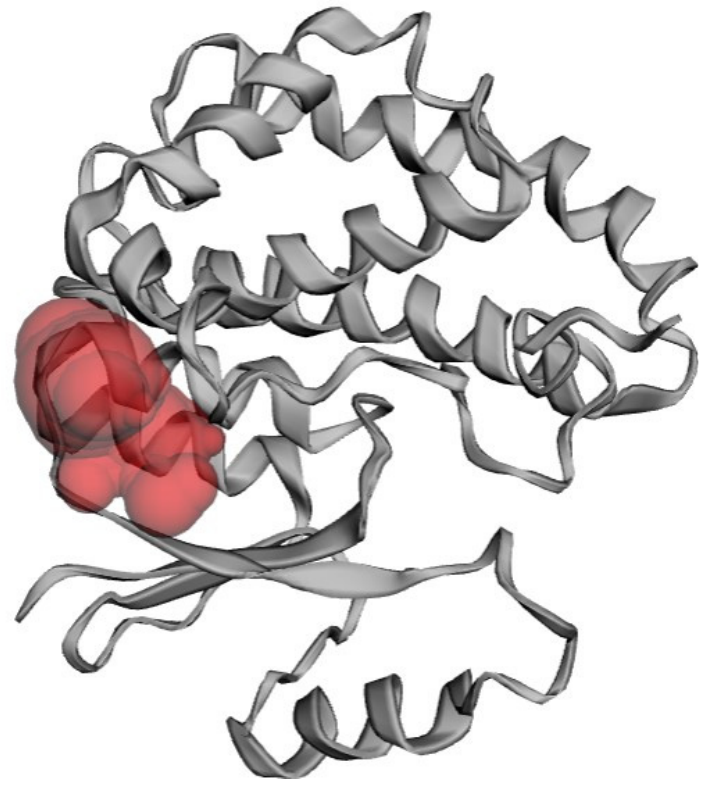
Figure 3. Determination of RmGST active sites using the CASTp server.